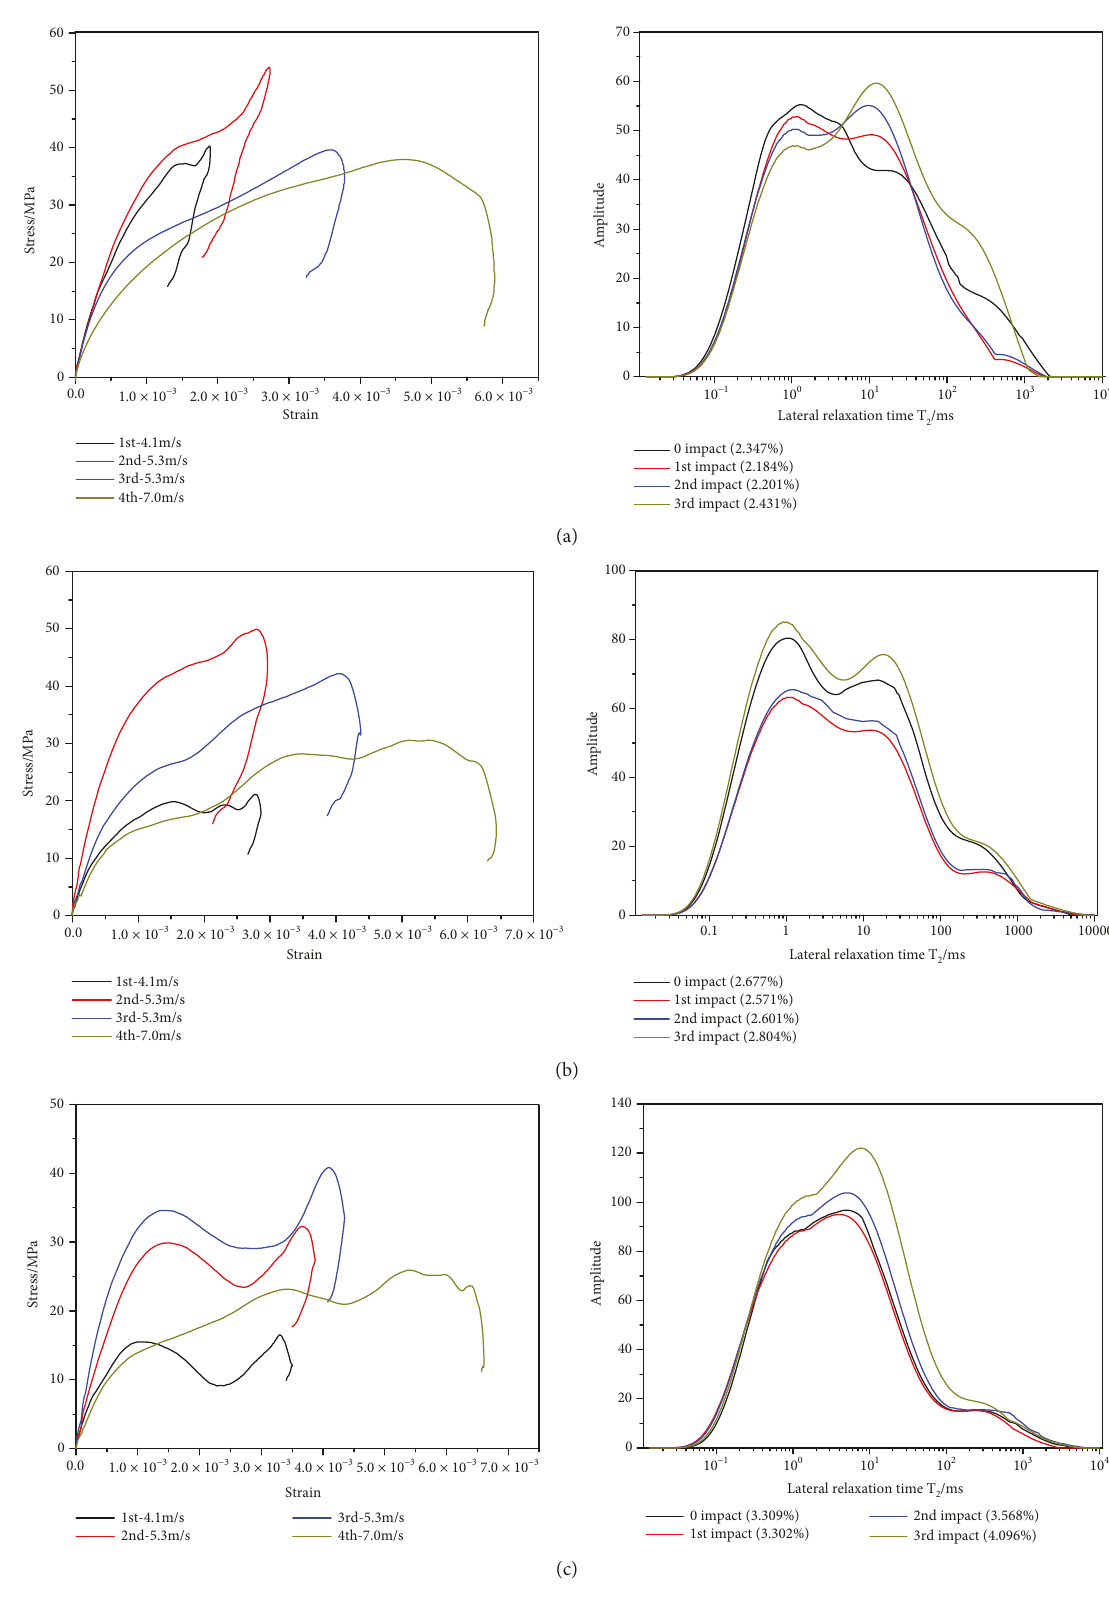
Figure 10: Stress-strain curve and T 2 spectrum of weakly weathered